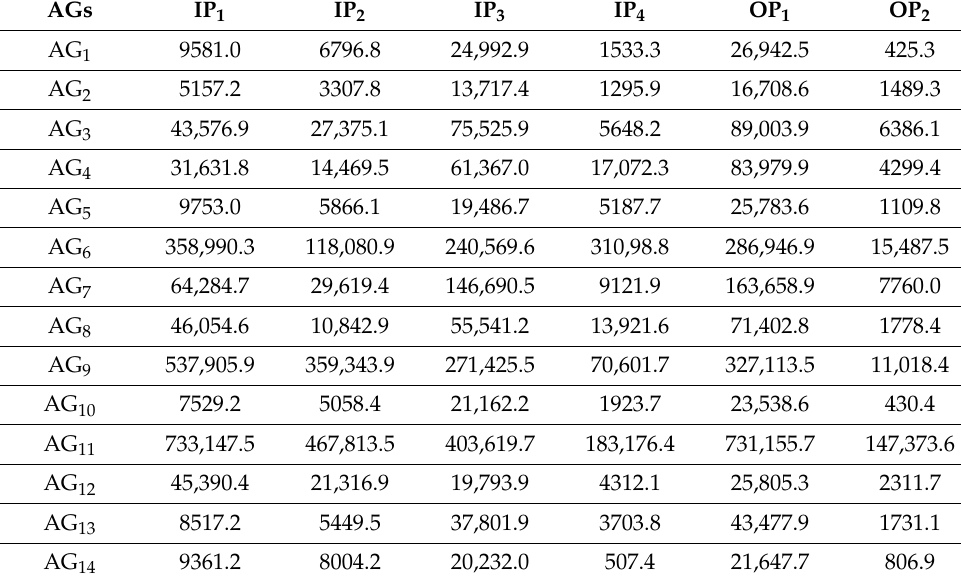
Table 6. Data in 2018 (Unit: 1000 USD).